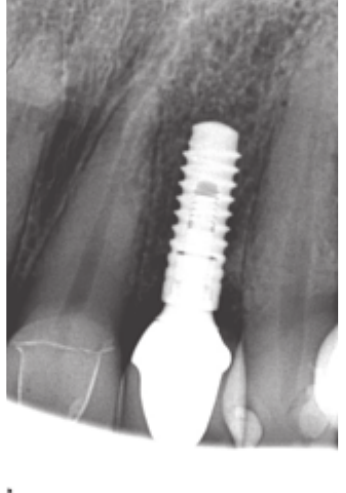
Figure 11: PA radiograph of provisional crown.